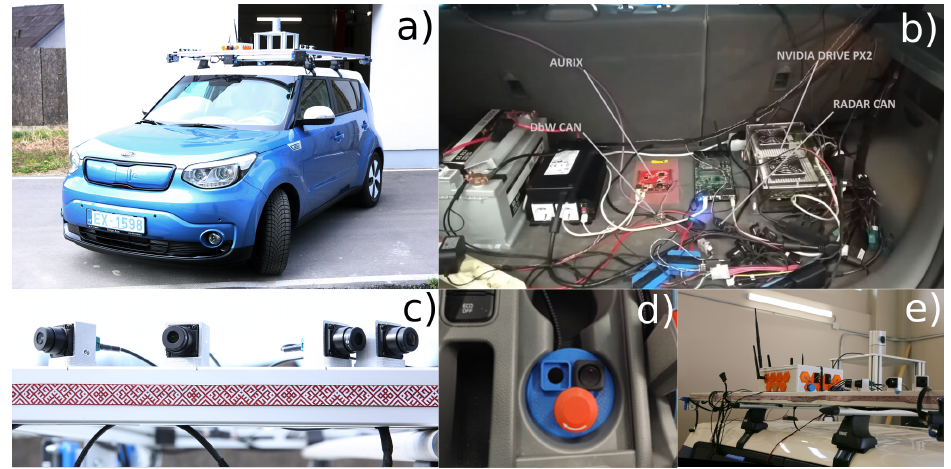
Figure 5. EDI perception system demonstrator. ( a ) EDI DbW car; ( b ) high-performance (NVIDIA PX2) and safety (Aurix TC3xx) controllers; ( c ) SEKONIX SD3323 camera mounting; ( d ) emergency button for exiting automatic mode; ( e ) EDI V2X